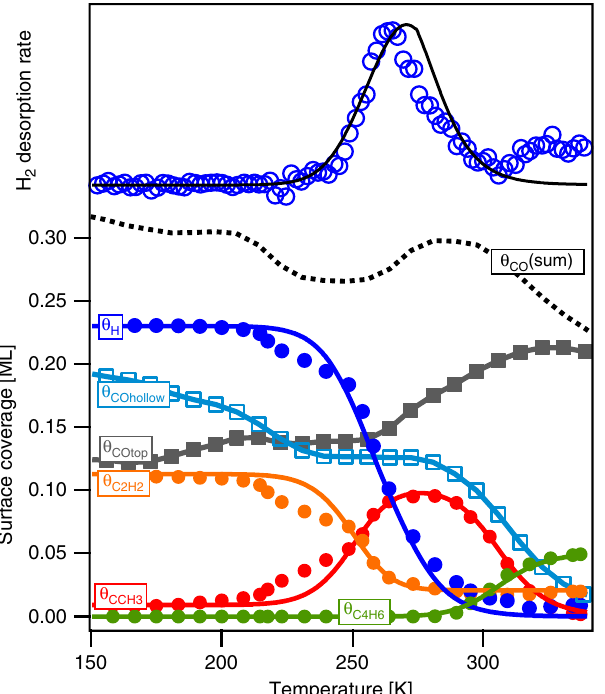
Fig. 6 Surface coverage during heating in CO. Markers show the surface coverages obtained from analysis of TP-XPS and TPRS during heating of a C 2 H 2ad /2H ad -covered Co(0001) surface in 1 × 10 − 7 mbar CO (0.2 K s − 1 ). The output of a mean fi eld microkinetic model is provided by the solid lines. The measured and simulated hydrogen desorption spectrum is added for comparison.